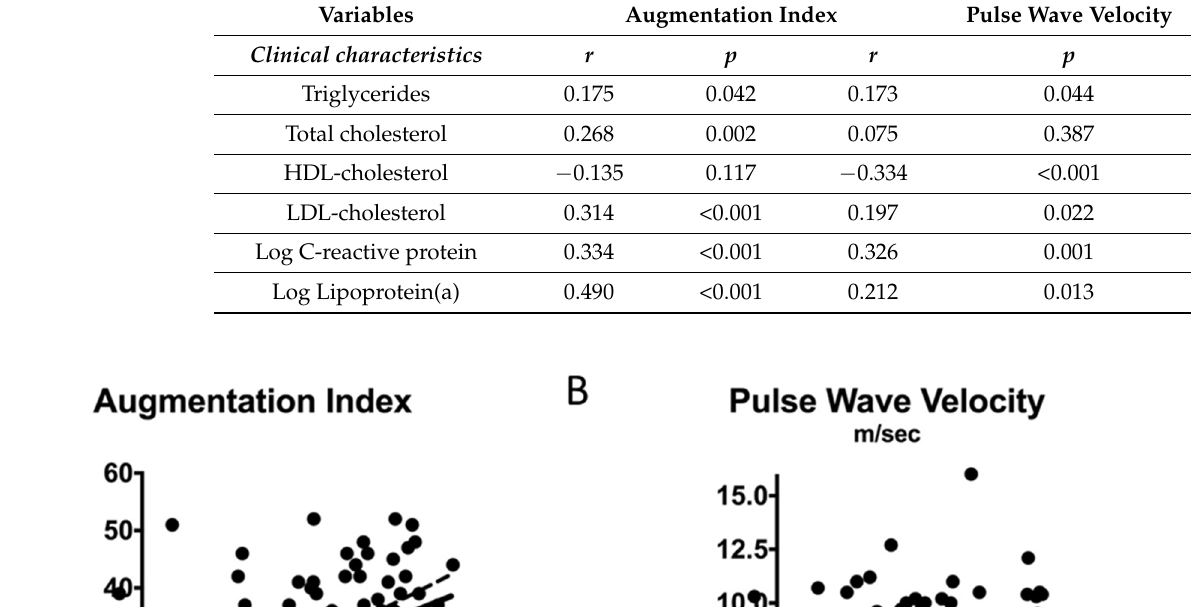
Table 3. Multivariate analysis with the augmentation index as the dependent variable.